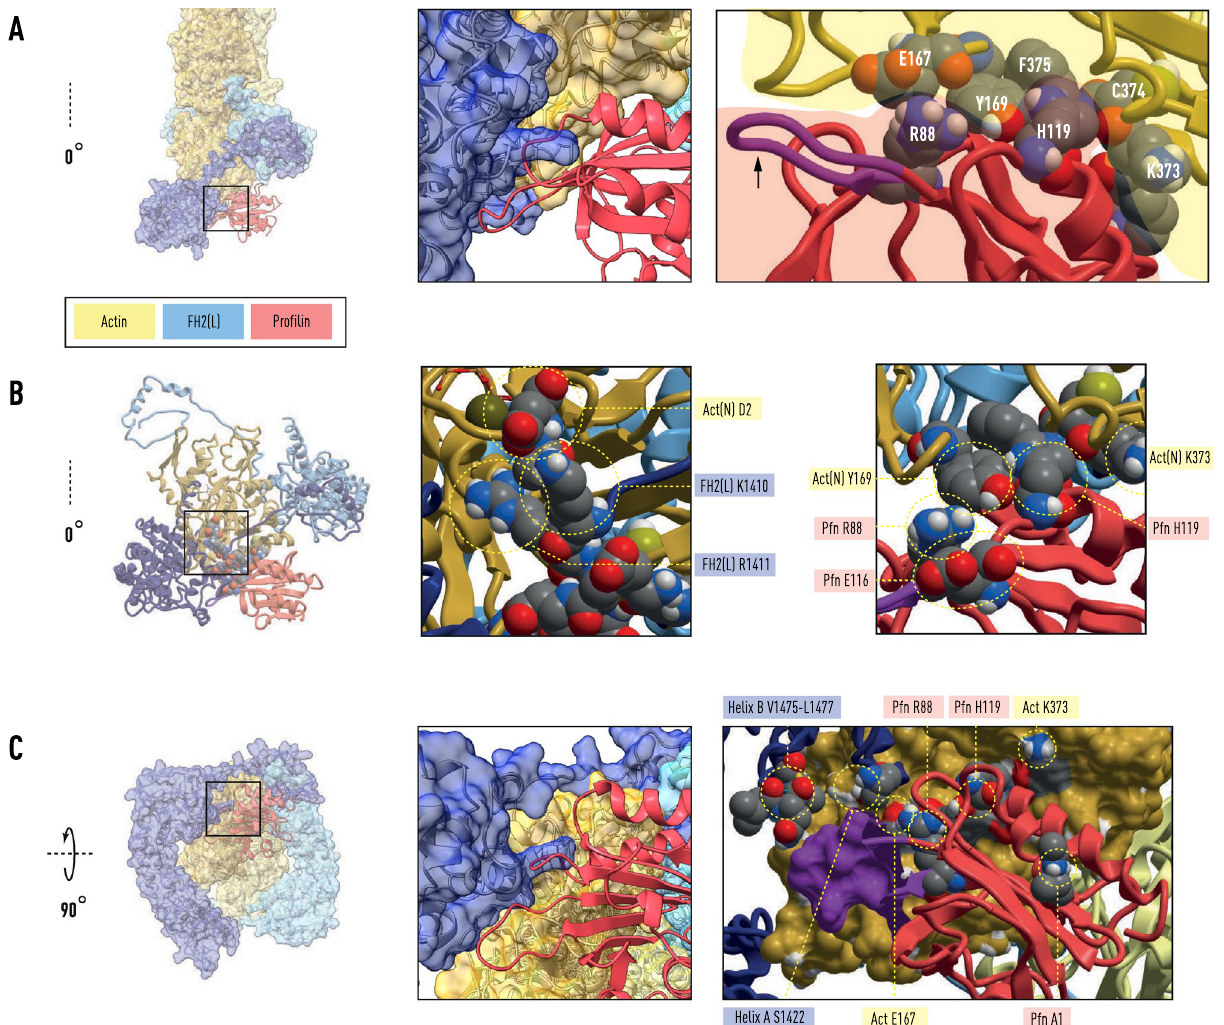
Figure 2. Central role for profilin R88 in coordinating actin polymerization by FH2. The boxed region of panel ( A ) shows profilin residues R88 and H119 sequestering Y169, the keystone residue in the longitudinal actin(N)-actin(N−2) interface. Actin residues K373, C374 and F375 form part of the pocket surrounding Y169. The arrow points to the prominent profilin ‘wing’ R88-T97 (purple). Panel ( B ), boxed region, shows (left) the interaction between actin(N) residue D2 and the FH2(L) linker residues K1410 and R1411. Detailed view (right image of panel B ) of profilin–actin interface shows the salt-bridge between R88 and profilin residue E116